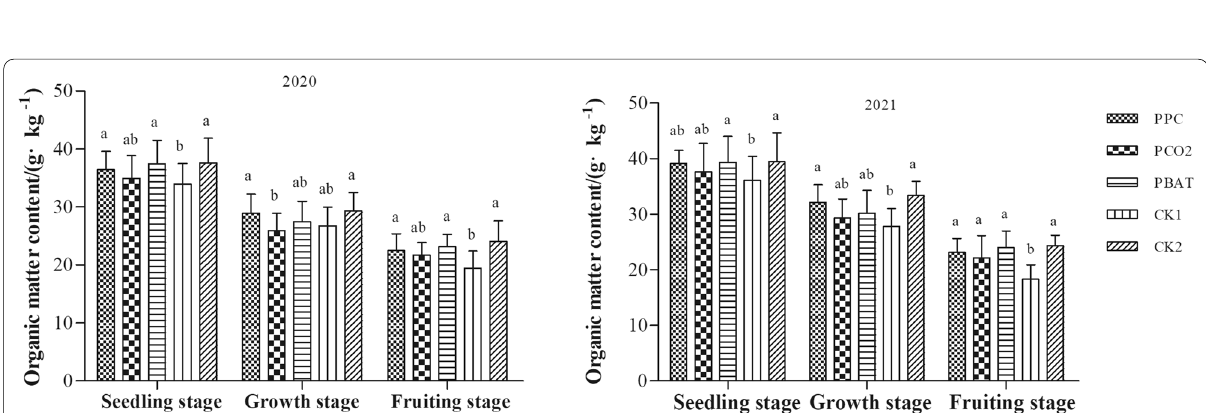
Fig. 4 Organic matter content in soil of different mulching treatment. Different lowercase letters indicate significant difference between treatments (P < 0.